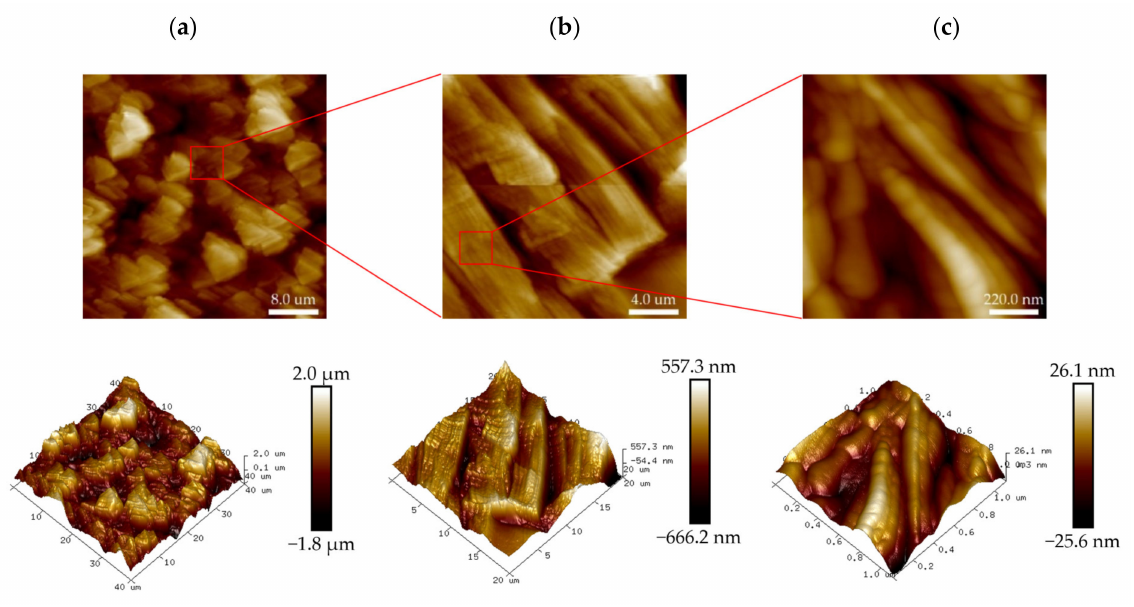
Figure 15. Two-dimensional (2D) and three-dimensional (3D) images of the PHRO gel in 1.6 wt% CaCl 2 solution with AFM. ( a ) Scanning area is 40.0 µ m × 40.0 µ m; ( b ) scanning area is 20.0 µ m × 20.0 µ m; ( c ) scanning area is 1.1 µ m × 1.1 µ